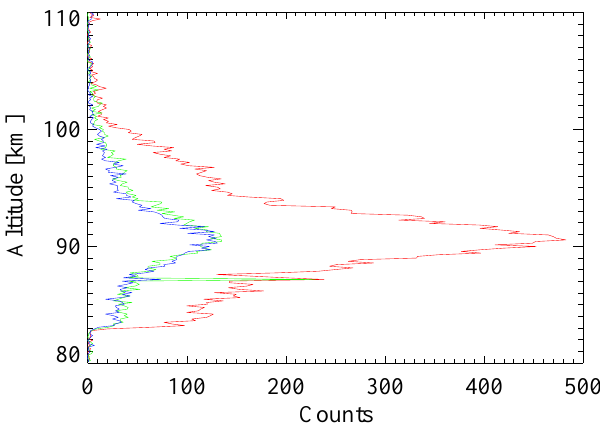
Fig. 2b. Sodium resonance signal (normalized photon counts) on 13 December 2010, 03:31:52UT. Each colour represents the 5-s in- tegral from one of the lidar frequencies. Solid red line: unshifted D 2 a frequency; green and blue lines: up- and downshifted frequen- cies. The Geminid meteor trail at 87km has a maximum of 240 counts. It is first visible at the D 2 a frequency (red line). The meteor trail was visible for 15s in the lidar beam and only in one altitude channel (150m). See text for